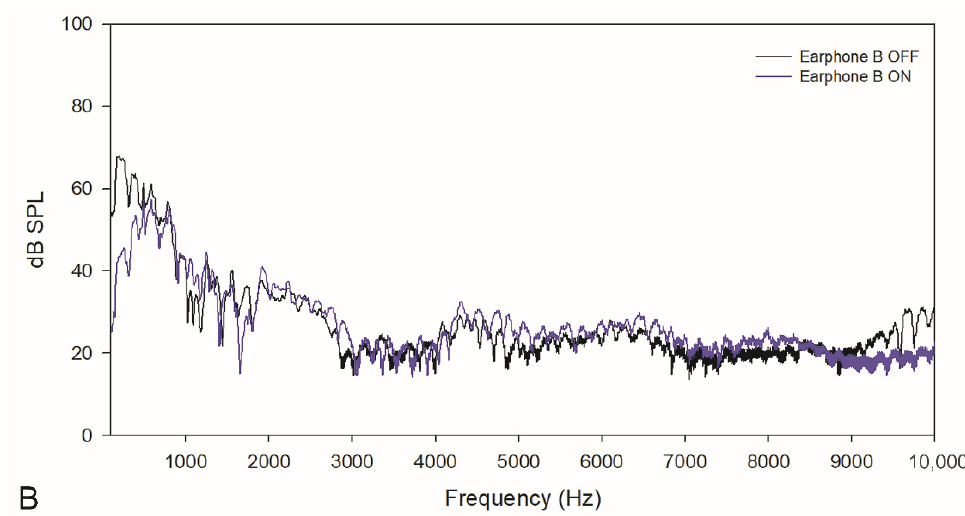
Figure 2. Acoustic characteristics of café noise in earphones ( A , B ).